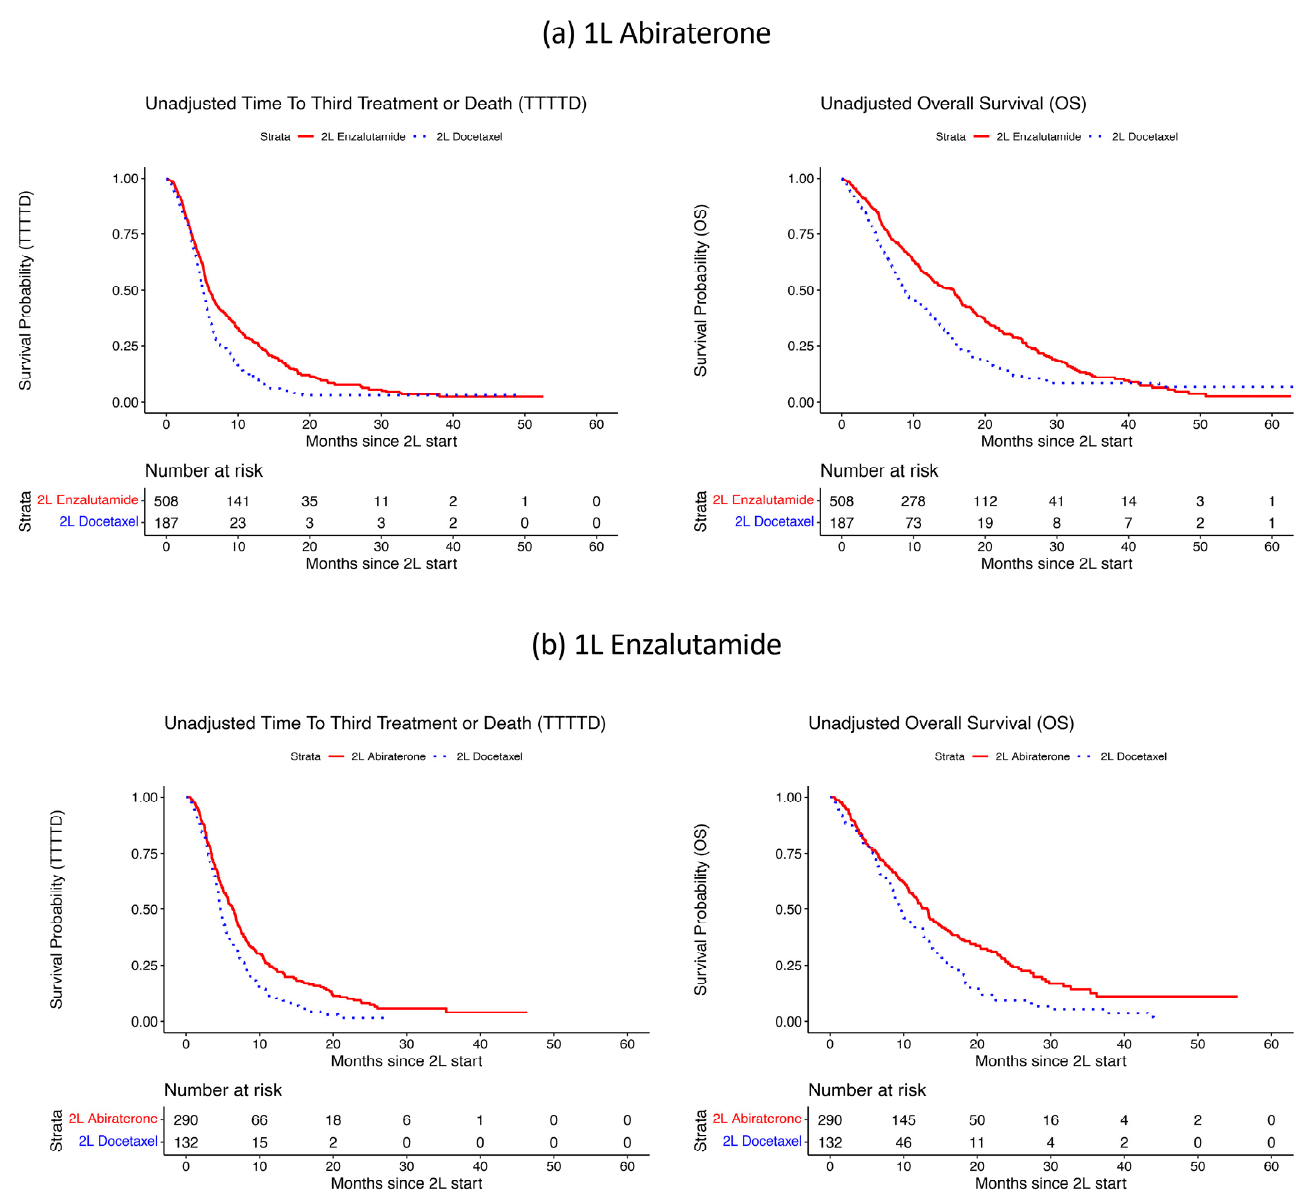
Figure 6. Unadjusted time to third treatment or death (TTTTD) and overall survival (OS) from 2L, with ( a ) 1L abiraterone (Figure 1a) and ( b ) 1L enzalutamide (Figure 1b).